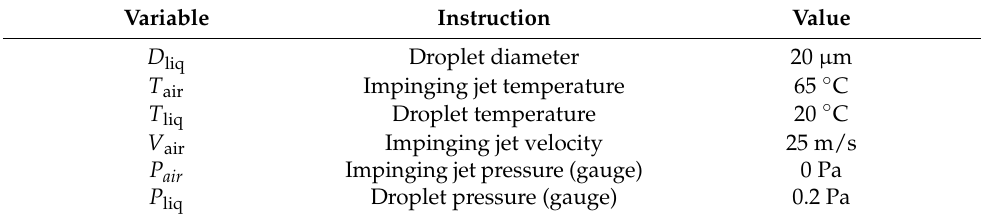
Table 1. Initial conditions for the drying of water-based ink droplets.